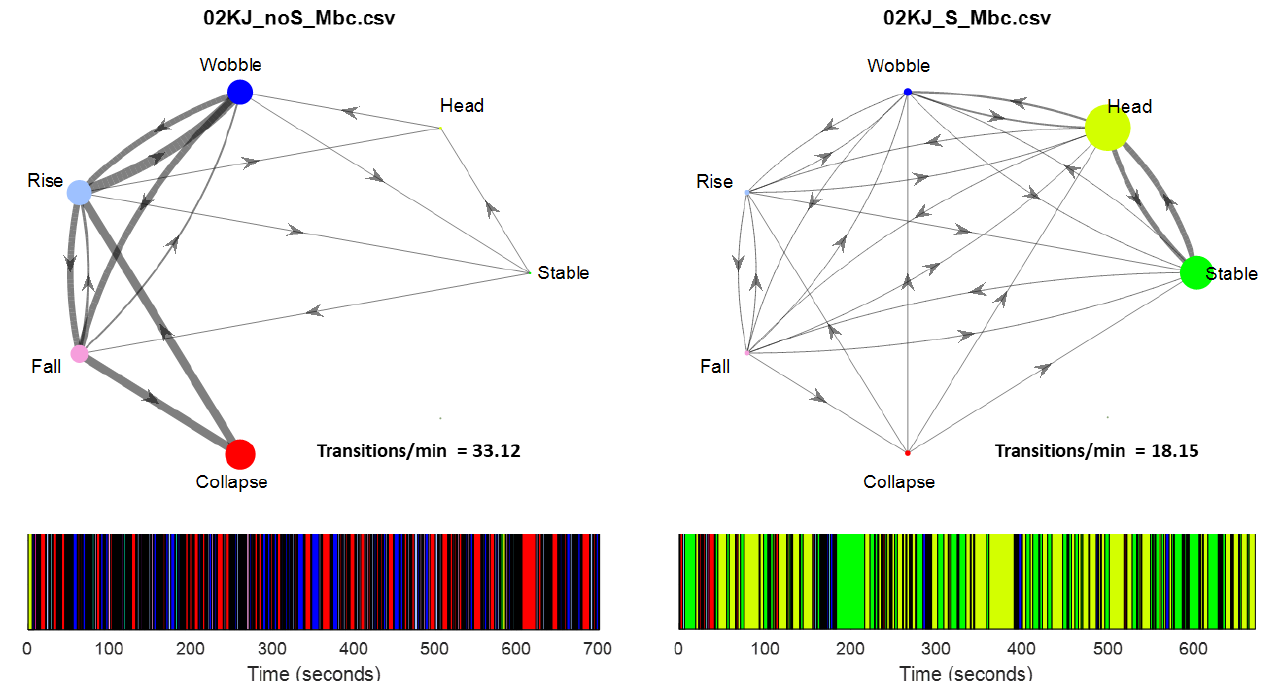
Figure 10. Example of the Markov model (top) and its associated behavior code time series (bottom). Left is the no support condition, and right is the support condition for the same subject. Stages (colored circles), amount of time spent in each stage (relative size of circles), transitions between states (lines with arrows), and frequency of transitions coming from each node (line thickness) are indicated in the Markov model. The transition and state scores for this child in the unsupported condition were 0.128 and 0.135, respectively. In the supported condition, the transition and state scores were 0.244 and 0.499 respectively.